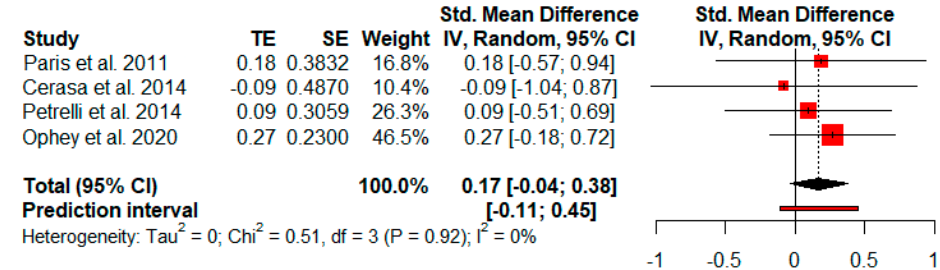
Figure 10 . Effectiveness of cognitive rehabilitation in visuospatial and visuoconstructive abilities.